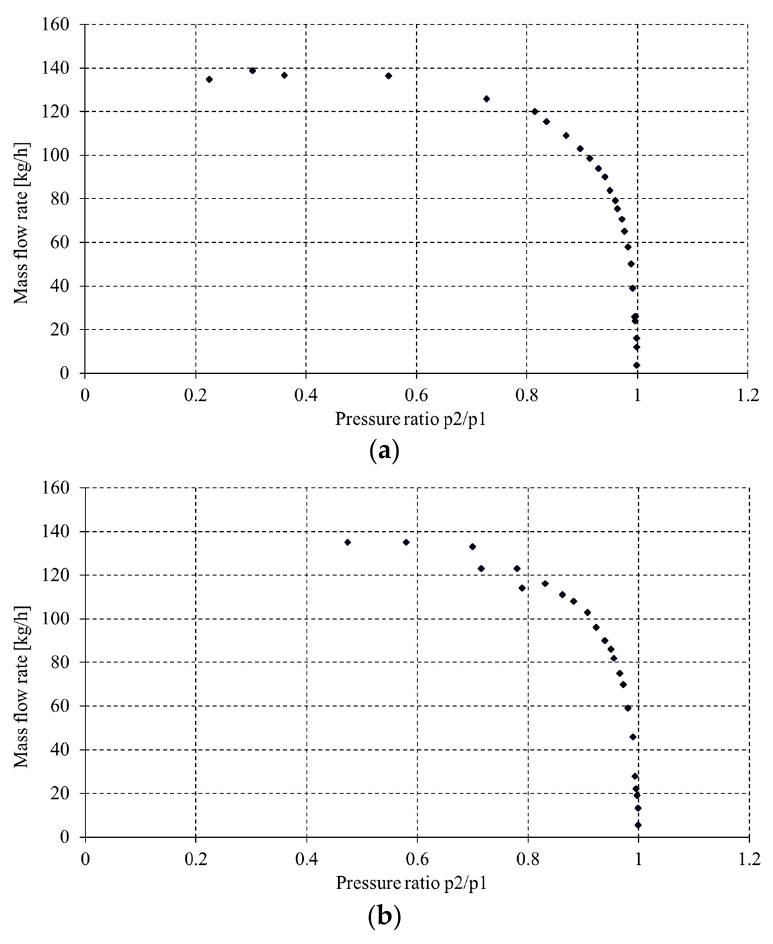
Figure 11. Dependence of the mass flow rate on the pressure ratio for the conduit: ( a ) 12 × 8 × 5, ( b ) 12 × 8 × 15.